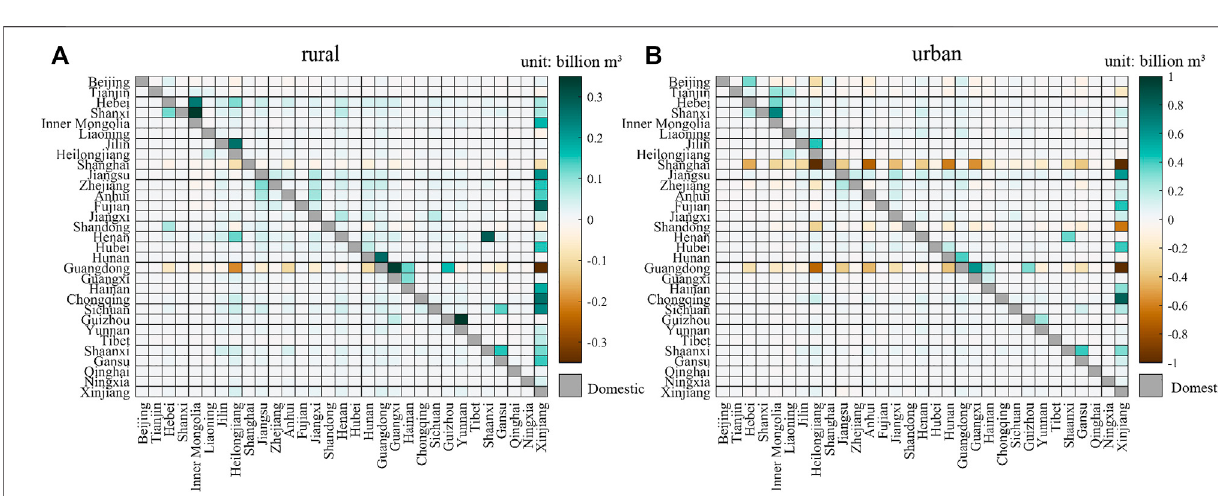
provinces (in fl uencing provinces) to the focal provinces, and the vertical axes show the water footprint transferred from the focal provinces to the other provinces (in fl uenced provinces).